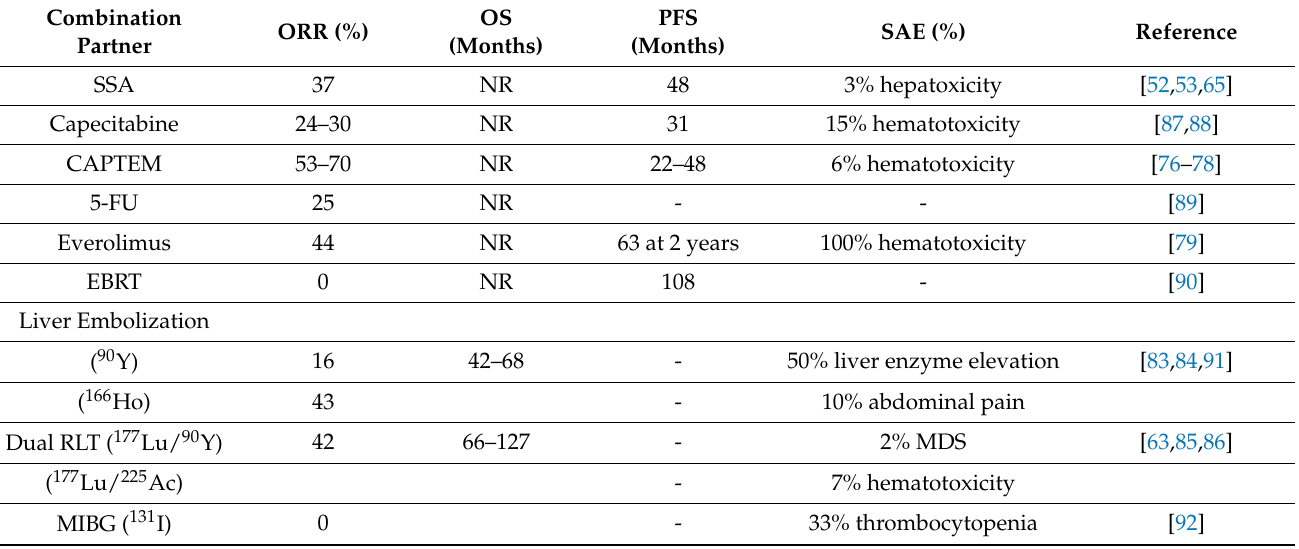
Table 3. Efficacy and safety of combination treatment with